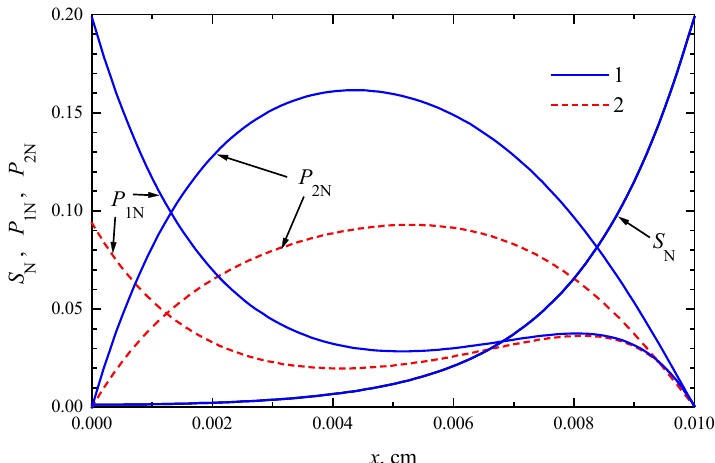
Figure 2 . The profiles of the normalized concentrations in the enzyme membrane of a CCE biosensor at time t = 124 s (1) when the steady-state is reached and t = 12 s (2) at the half of it. Other parameters and notation are the same as in Fig.